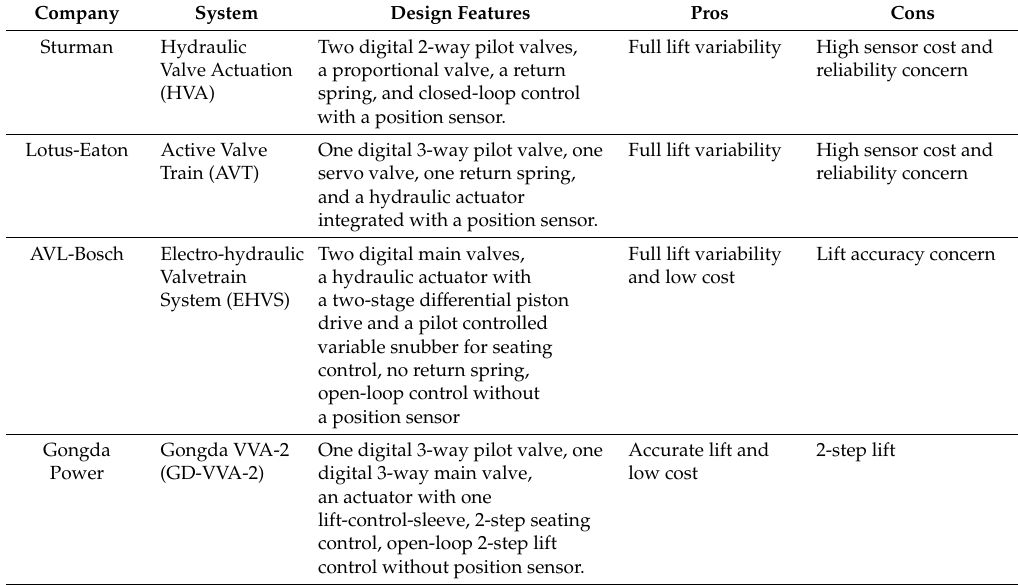
Table 2. Some major electro-hydraulic VVA (EHVVA)